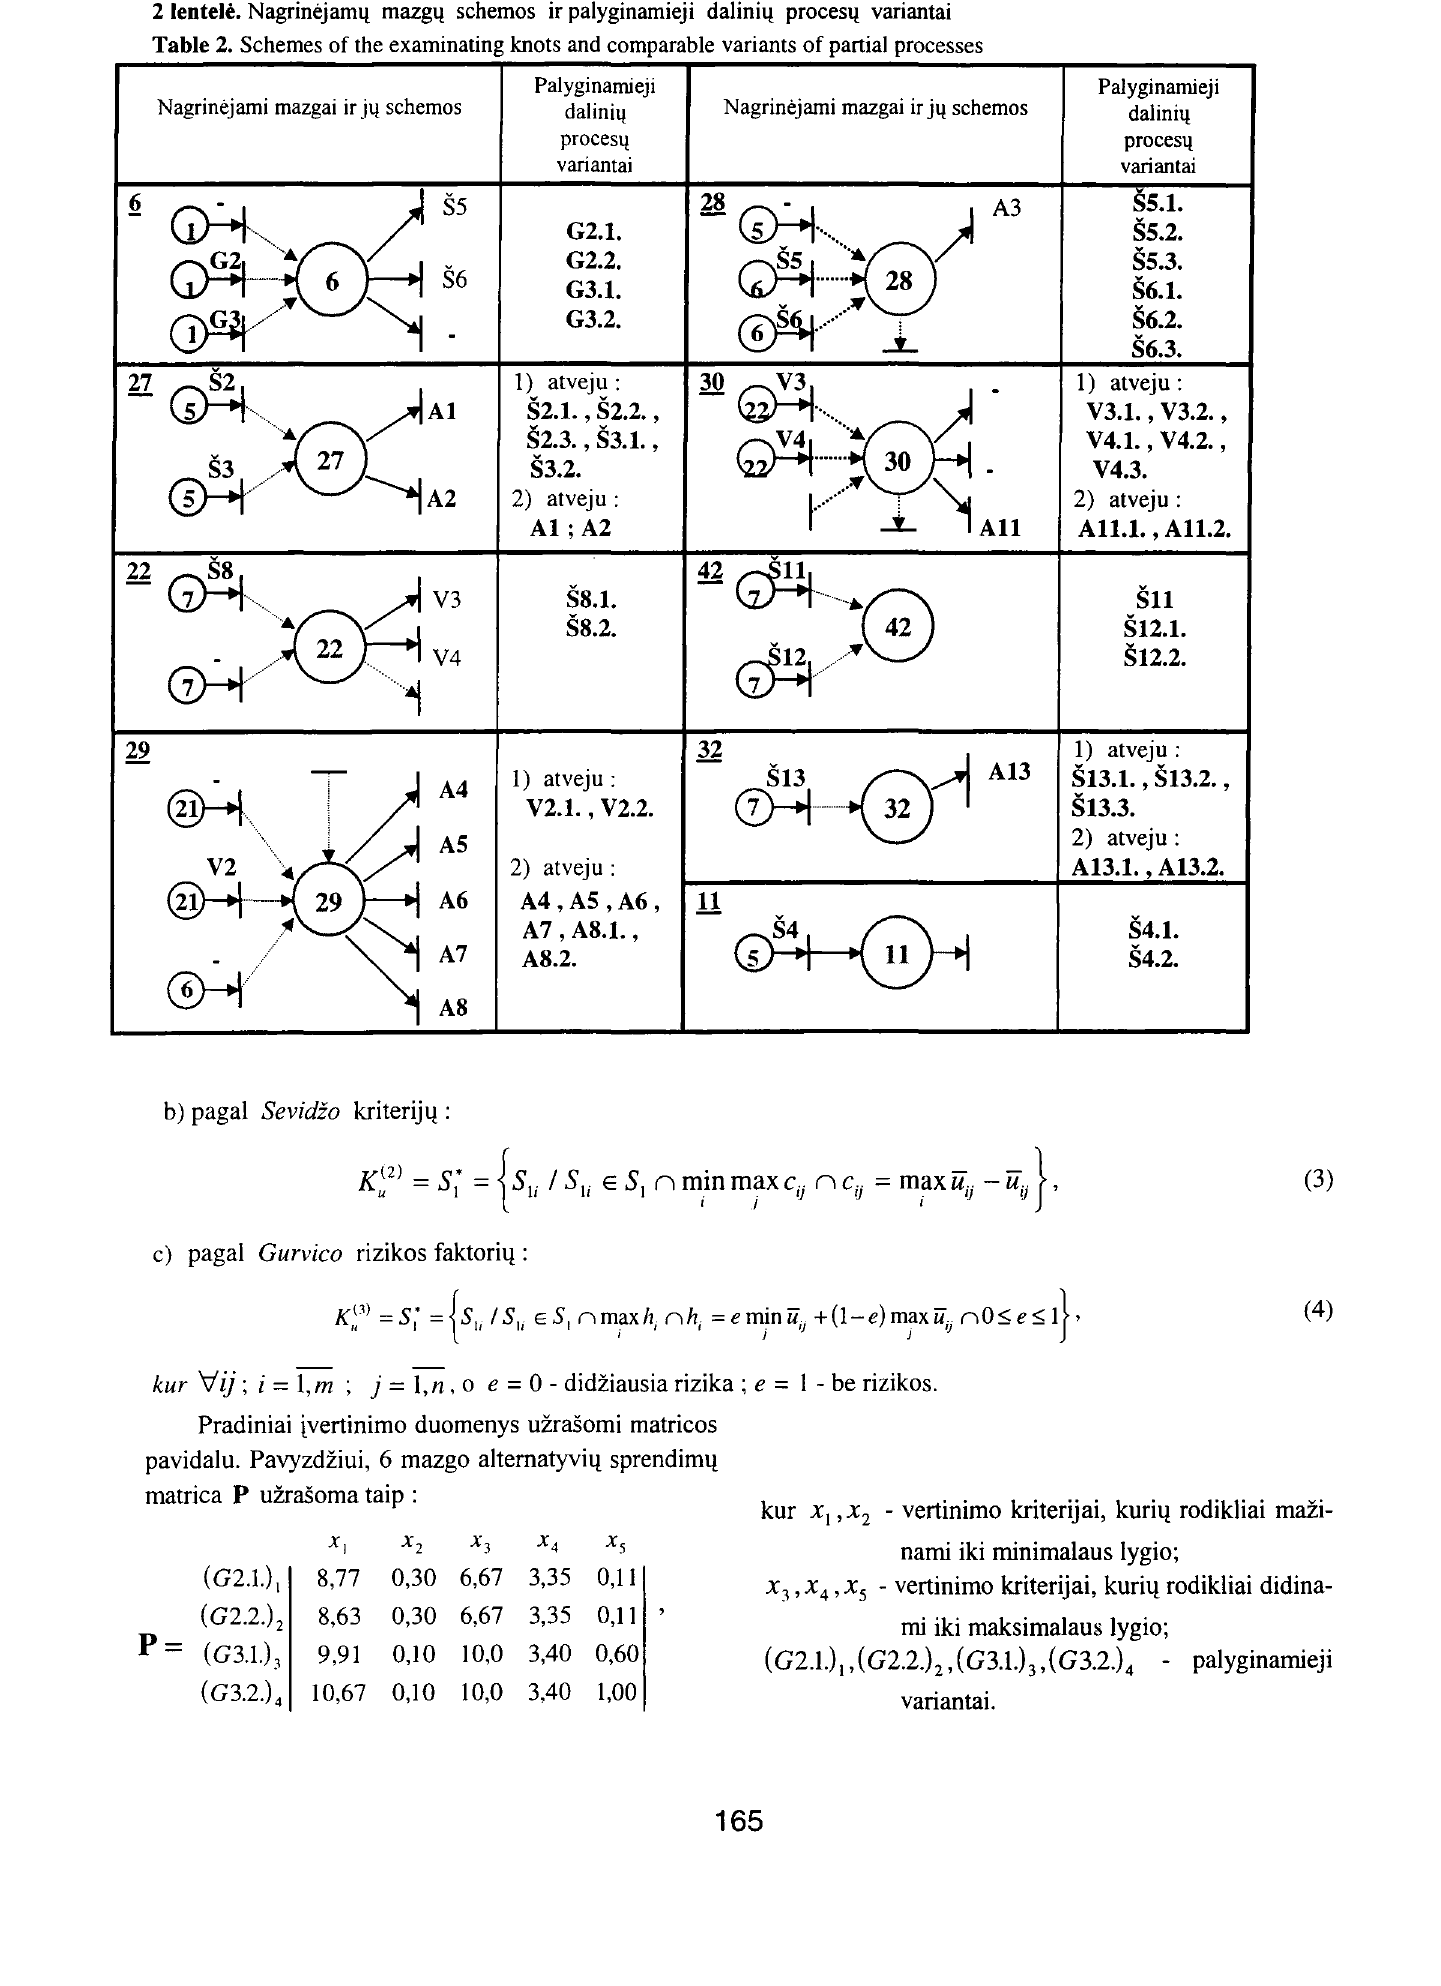
Table 2. Schemes of the examinating knots and comparable variants of partial